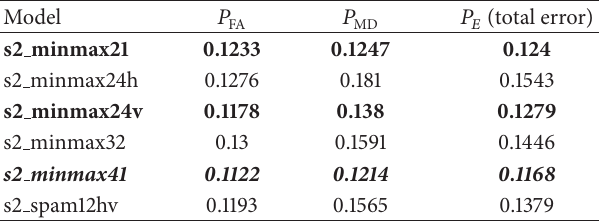
Table 2: Detection results of the second order submodels. Model